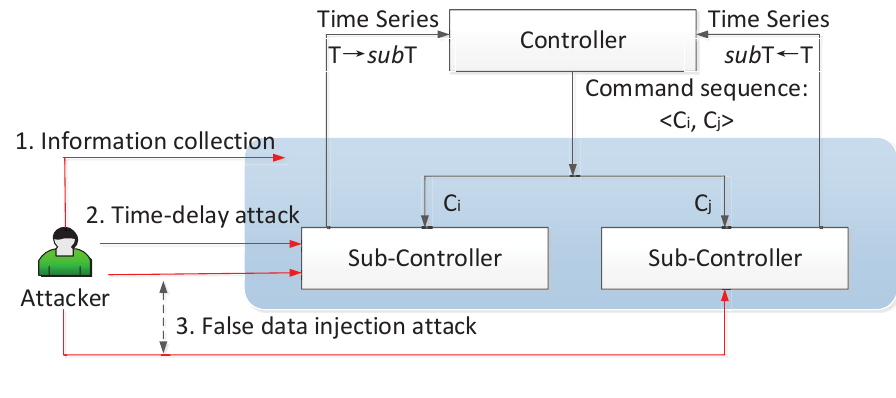
Figure 4. Attack